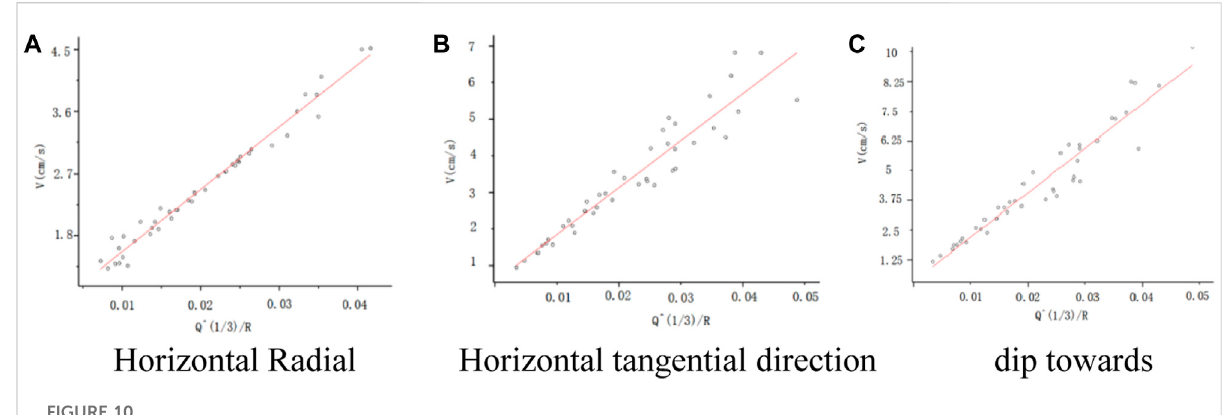
FIGURE 10 Regression curve of measured vibration velocity of step